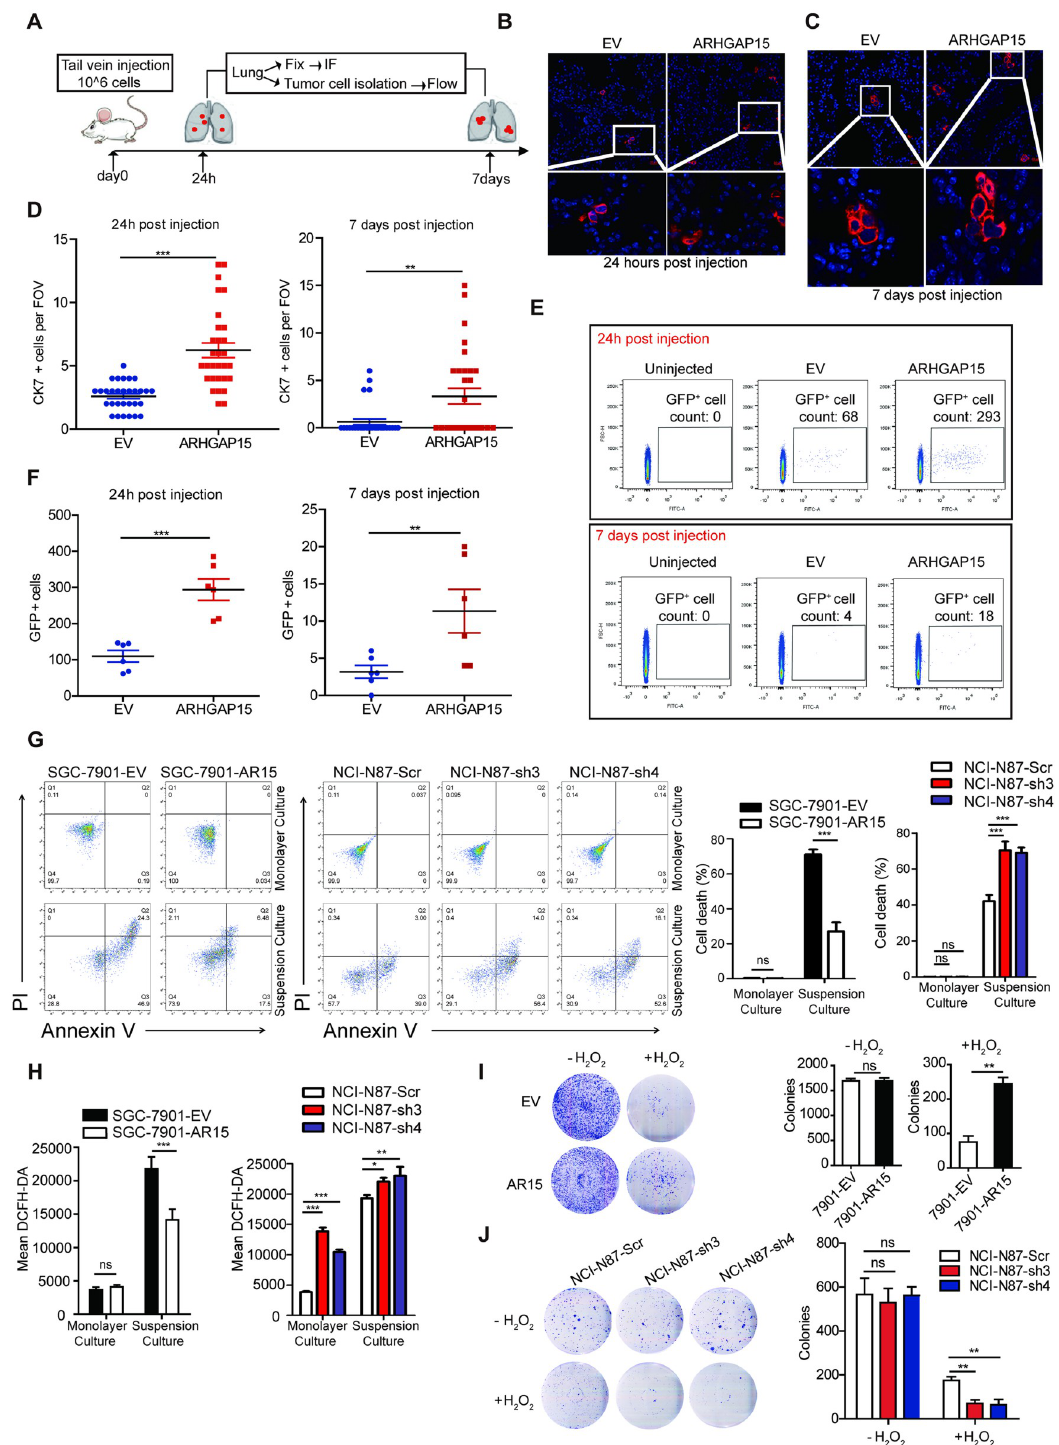
Fig 3. ARHGAP15 promotes ECM-detached tumor cell survival and colony formation under oxidative stress. (A) : Schematic representation of studying gastric tumor cell survival in vivo . 10 6 cells were injected and then the number of the survived tumor cells in the lung was quantified at indicated time points. (B-D) : The tumor cells were recognized by anti-CK7 antibody in immunofluorescent staining. Survived tumor cells in lungs were quantified at 24 hours ( B and D ) and 7 days ( C and D ) post injection. 3 mice per group and tumor cells from 30 field of views (FOV) for each group were counted. (E-F) : The injected tumor